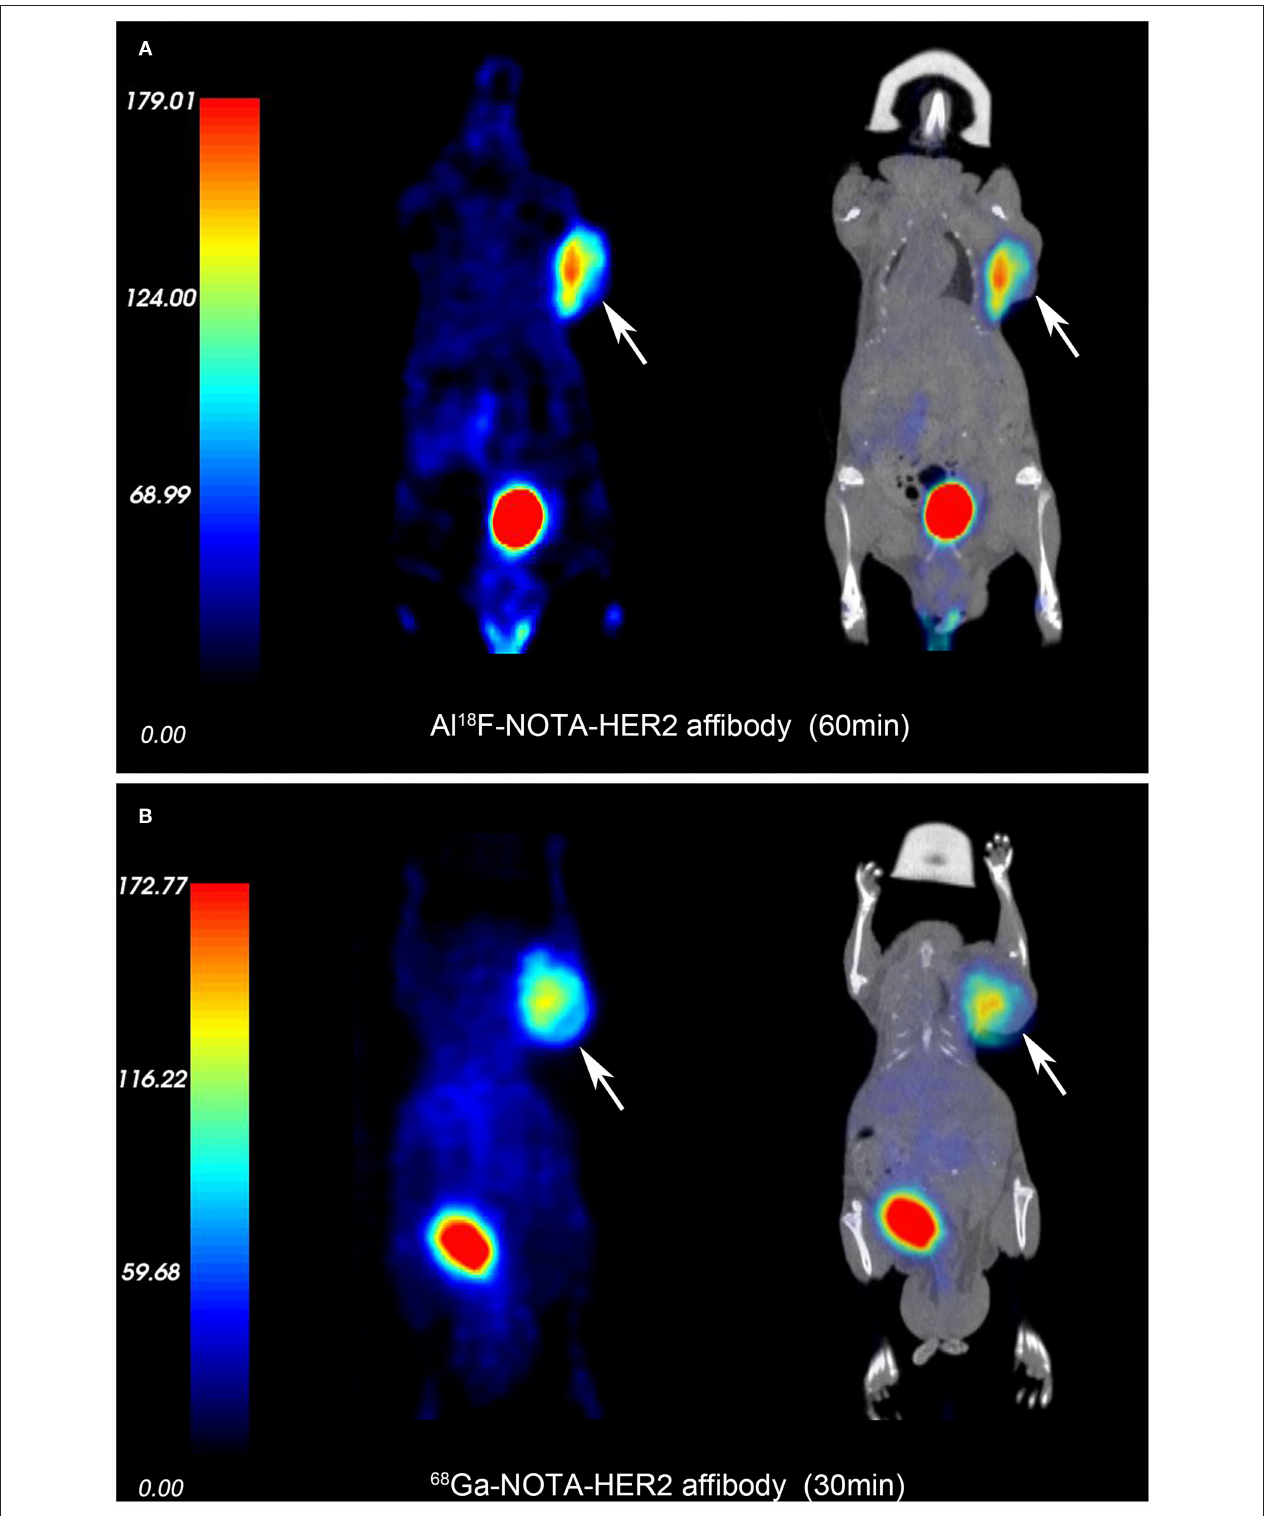
FIGURE 6 | PET and fusion images of the [ 18 F]AlF-NOTA-HER2 affibody (A) and 68 Ga-NOTA-HER2 affibody (B) in mice-bearing NCI-N87 by micro-PET/CT. White arrows indicate xenografts.